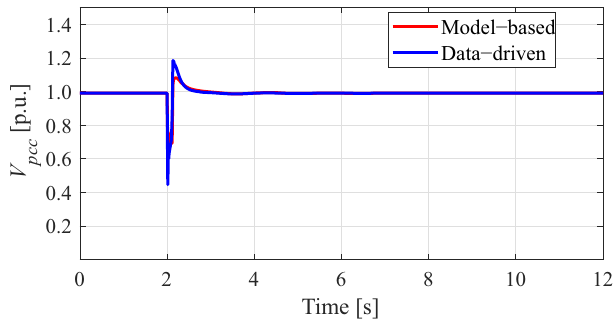
Figure 9. Voltage control during transient fault at Bus 7. Figure 10 confirms the robustness of the proposed approach because the power flows between the interconnected areas, active and reactive powers, present smaller power oscillations than the generated with the conventional control. For instance, Figure 10a shows significant differences during the transient behavior of the active power, while Figure 10b displays the results of the reactive power.